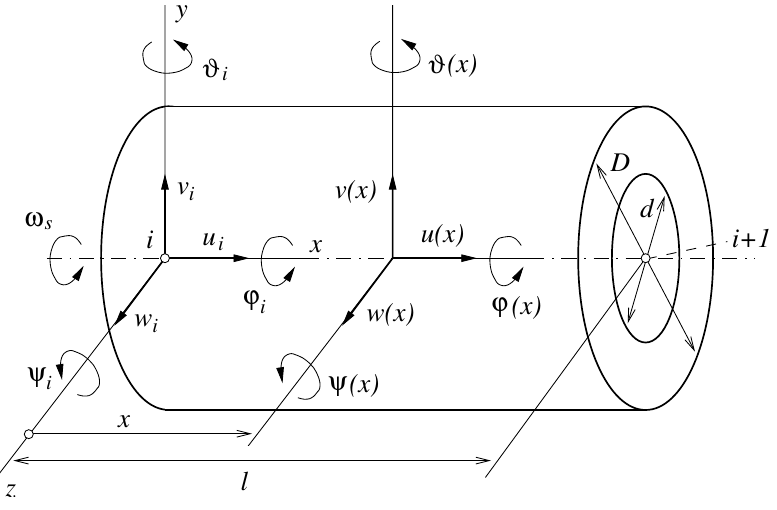
Figure 2. Schematic view of a shaft finite